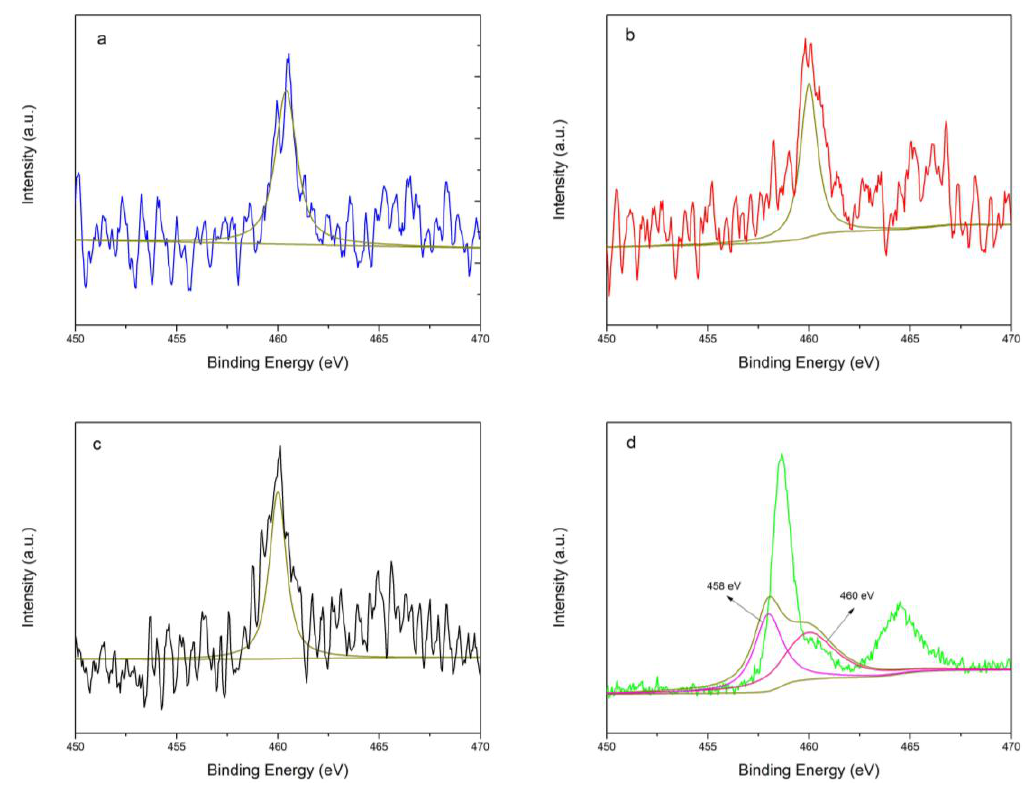
Figure 8. XPS spectra of TS-1 ( a ), TS-1 used once ( b ), TS-1 used four times ( c ), and commercial TS-1 ( d ).